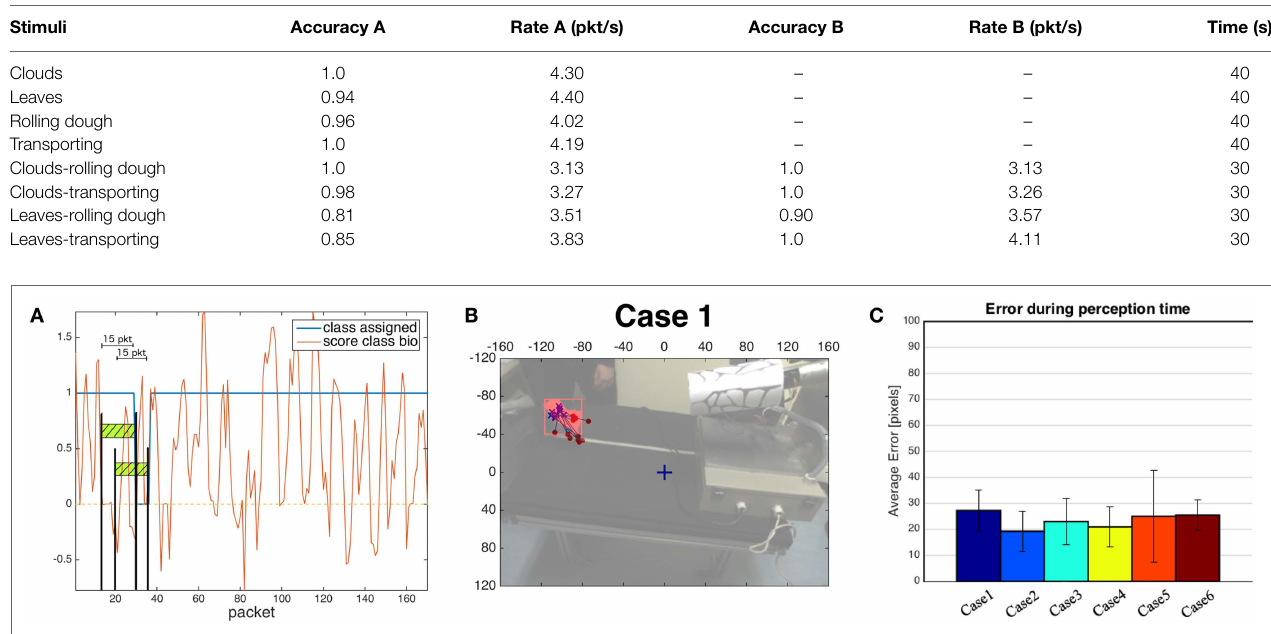
FIGURE 8 | (A) An example of the classifier generating response messages— Rolling dough case (bio = 1, non-bio = (cid:0) 1, “?” = 0). (B) An example of perception errors, computed as the distances between the locations identified by the color segmentations (blue crosses) and the corresponding positions individuated by the biological motion detector (red dots). The dots and the crosses are printed on a more transparent version of the scene extracted from the robot point of view before the beginning of the oculomotor action. (C) Average perception error in all cases. For the detailed list see Table 4 .